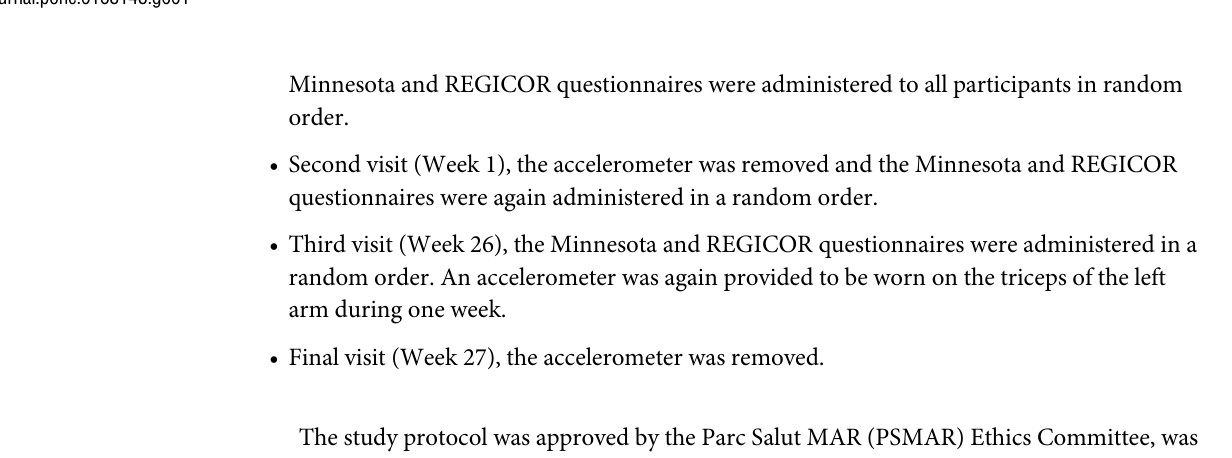
Fig 1. Design of the study: scheduled visits and measurements undertaken at each